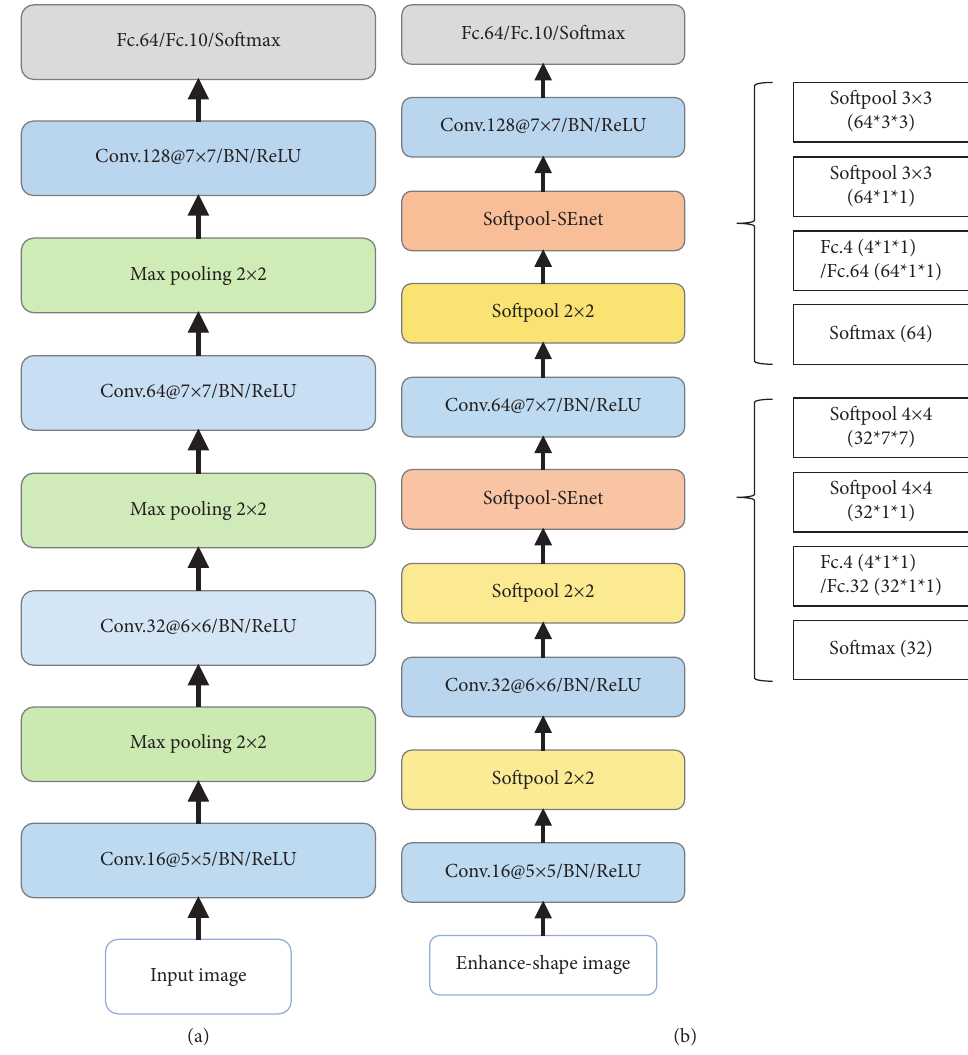
Figure 9: Network structure. Next to the network structure is the size of the feature map. (a) CNN. (b) Enhanced-shape